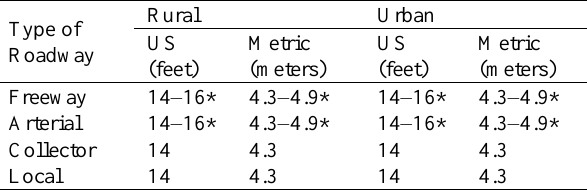
Figure 13. Clearance report information